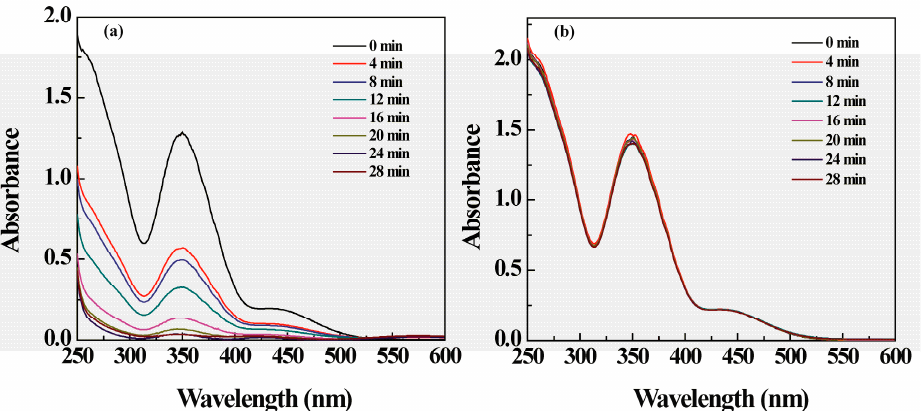
Figure 4. UV-vis spectra of the reaction solution treated with ( a ) iron/palladium nanoparticle (Fe/Pd NP)-assembled filter paper and ( b ) Fe/Pd-free filter paper at different time intervals.